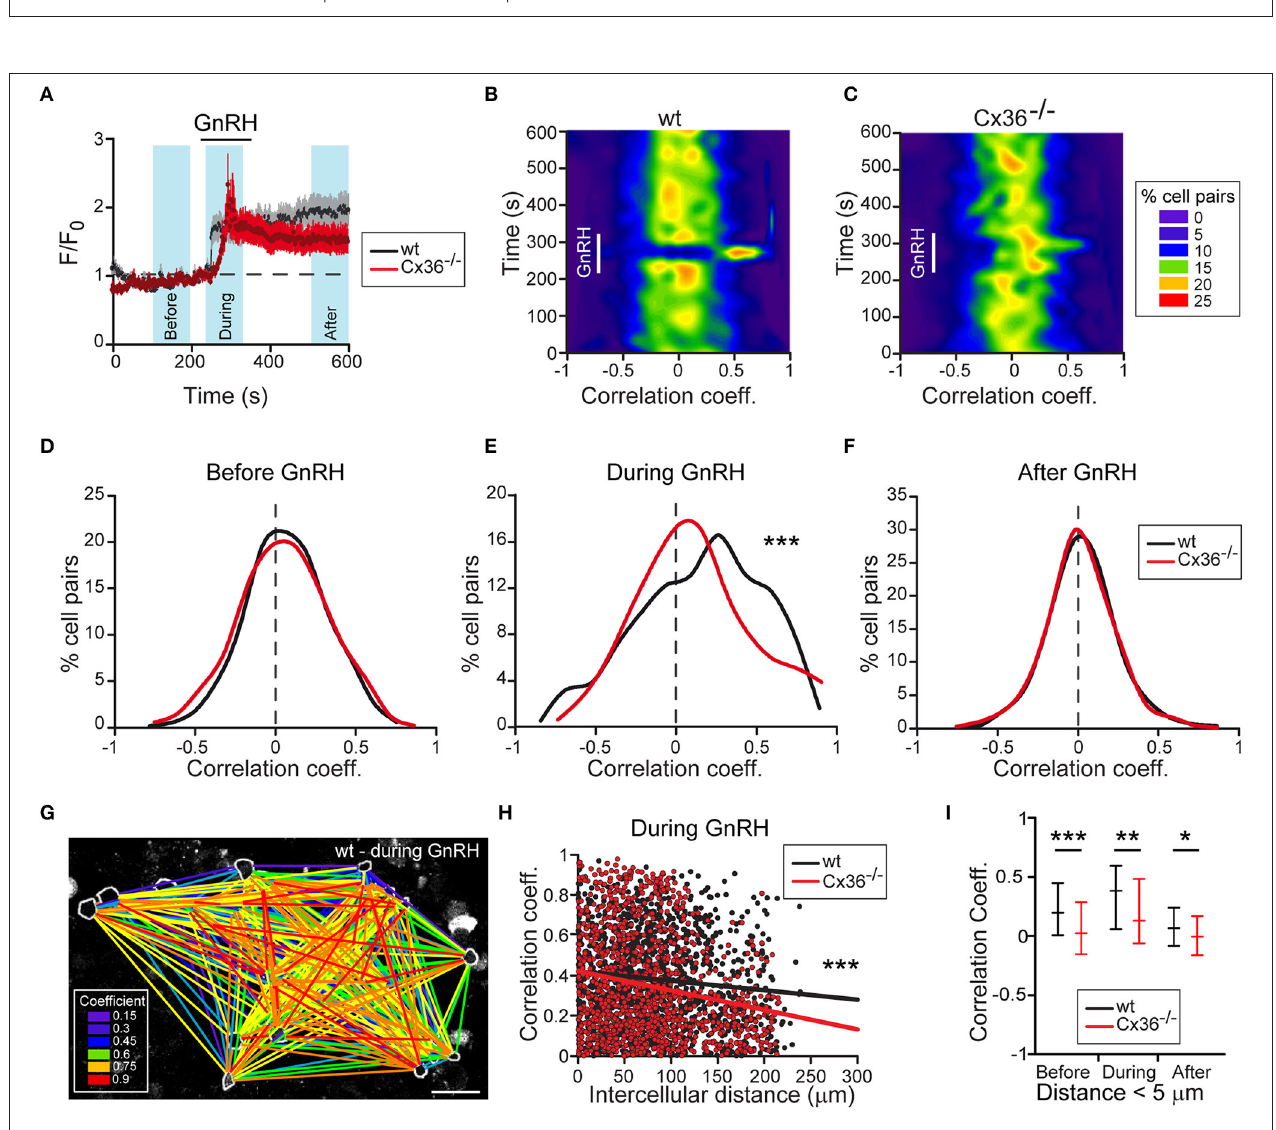
FIGURE 3 | Deficient electrical coupling between gonadotropes in Cx36 − / − mice as revealed by Ca 2 + imaging. (A) GnRH-induced calcium response in wt and Cx36 − / − AP. Representative examples of averaged recordings from one experiment. GnRH (1nM) was applied for 2min. Number of cells: wt n = 32; Cx36 − / − n = 14. Data represent mean ± SEM. Blue areas represent time windows selected for statistical analysis. (B,C) GnRH evokes stronger and more coordinated responses in wt (B) than in Cx36 − / − (C) pituitaries. Representative heat maps from one wt and one Cx36 − / − AP (528 and 351 cell pairs, respectively) showing temporal dynamic changes of correlated activity (Spearman coefficient). (D–F) Cx36 ablation effects GnRH-induced, but not basal synchrony. Distribution of Spearman correlation coefficients for cell pairs before (D) , during (E) , and after (F) GnRH application. Although some cell pairs displayed high coefficient correlation values, no large-scale synchrony was observed before GnRH application. Seven experiments/genotype; wt n = 1908; Cx36 − / − n = 1951 cell pairs, Mann–Whitney Rank Sum Test. *** P ≤ 0.001. (G) Illustrative example of one correlation map identifying GnRH-responsive cell pairs in wt mice during GnRH application. All GnRH-responsive cell pairs are connected with lines. Colors represent the correlation intensity according to Spearman correlation coefficients. Scale bar: 25 µ m. (H) Comparative linear regression analysis between the positive values of Spearman correlation coefficients and intercellular distances showing that only during GnRH application the slopes are significantly different when comparing wt and Cx36 − / − . For more details, see Supplementary Figure S3. Seven experiments/genotype; wt n = 1908; Cx36 − / − n = 1951 cell pairs. *** P ≤ 0.001. (I) Synchrony between Cx36 − / − cells is decreased also before and after GnRH application when considering only short-distance coupling ( < 5 µ m). Spearman correlation coefficients obtained from 7 experiments/genotype, wt n = 82; Cx36 − / − n = 93 cell pairs, median [IQR], Mann-Whitney Rank Sum Test. * P ≤ 0.05, ** P ≤ 0.01; *** P ≤ 0.001.